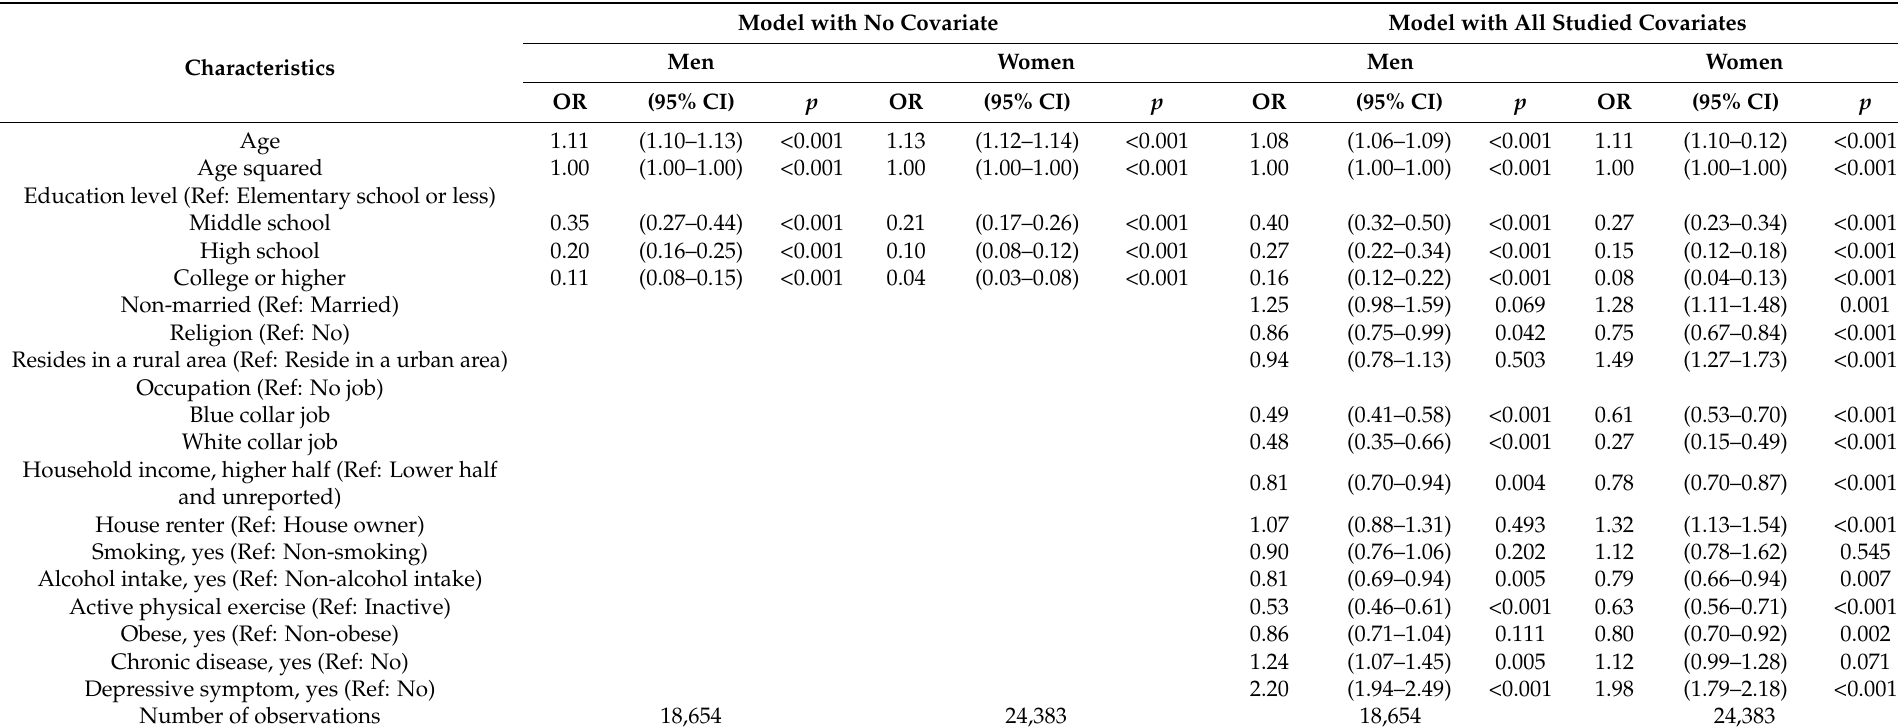
Table 3. Associations of age and education with cognitive impairment by gender for all observations of all considered waves.